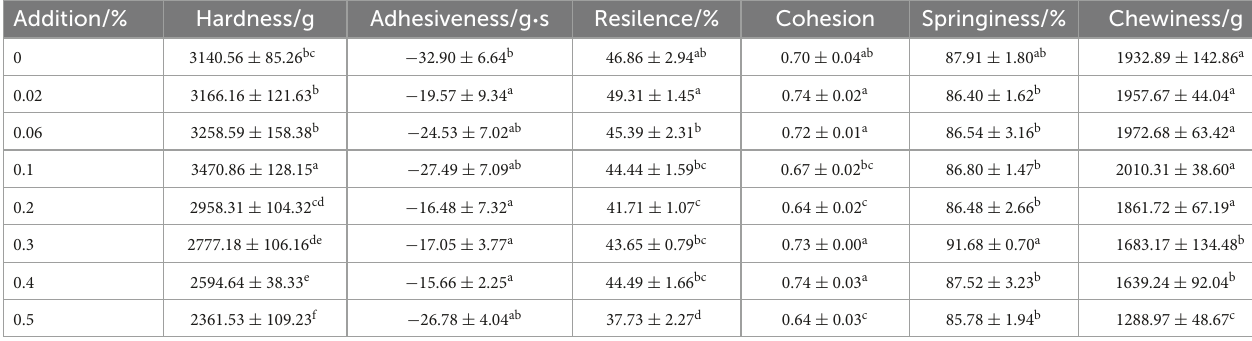
Valuesarepresentedasthemean ± SDofthreereplicatesamples.Thismeansinacolumnthatsharesthesamelettersdonotsignificantlydiffer( p < 0.05).